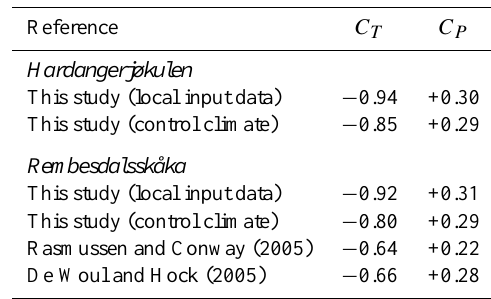
Table 4. Static mass balance sensitivities to a 1K change in